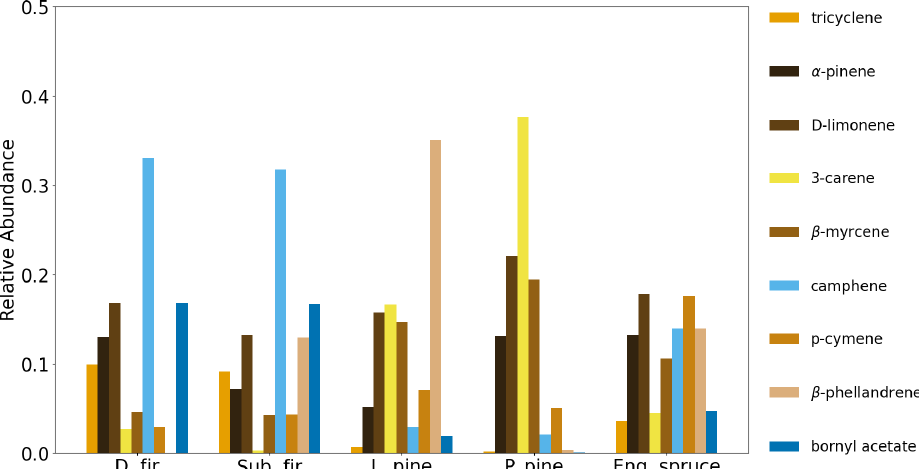
Figure 3. Normalized emission ratio profiles for Douglas fir, subalpine fir, lodgepole pine, ponderosa pine and Engelmann spruce based on manual compound selection.